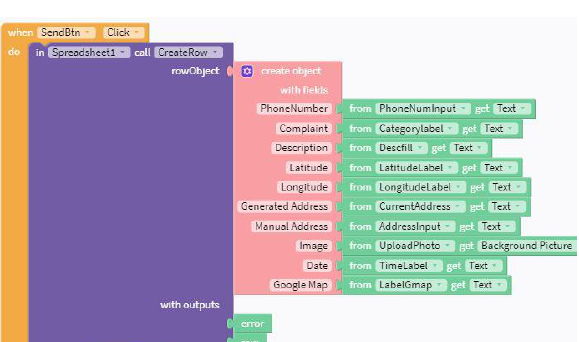
Figure 3. Use case diagram of complaints for developed mobile application